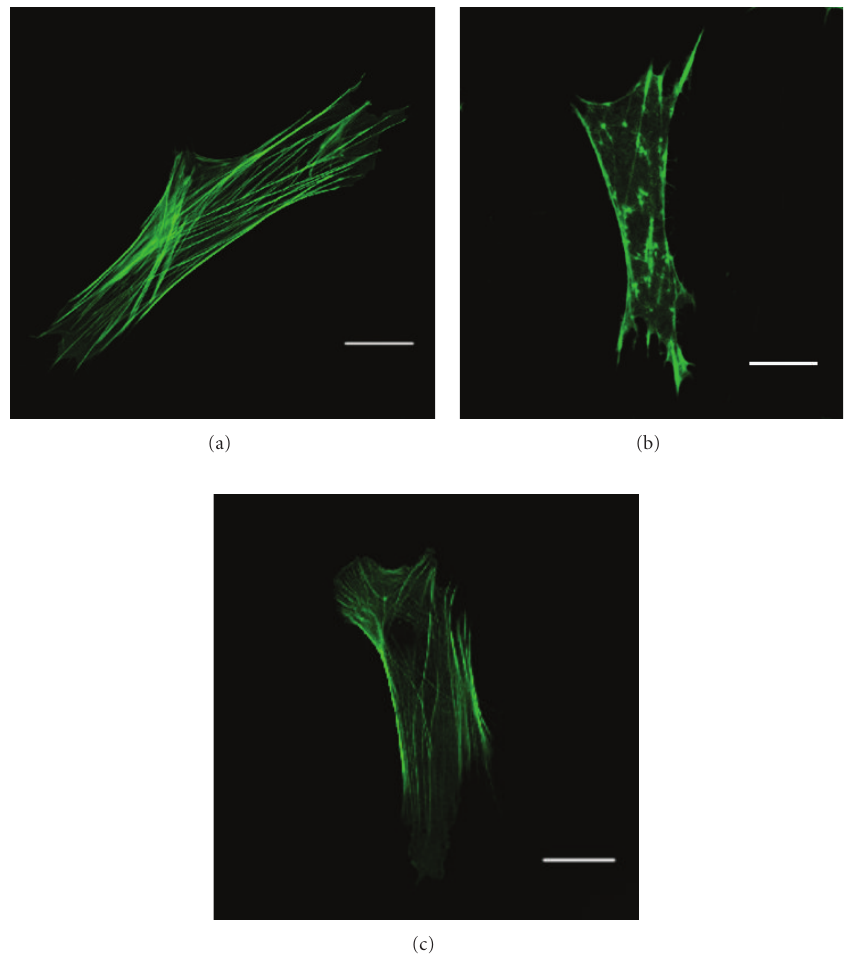
Figure 6: F-actin visualization by phalloidin labeling as analyzed by confocal microscopy. Scale bar = 10 μ m (A: control group; B: injury group; C: Verapamil-treated